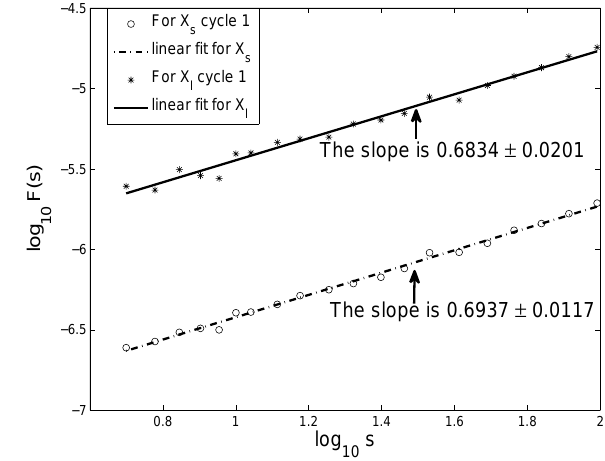
Fig. 4. Examples for obtaining the exponent h( 2 ) in MF-DFA. The linear fit range is s = 5 to 98.